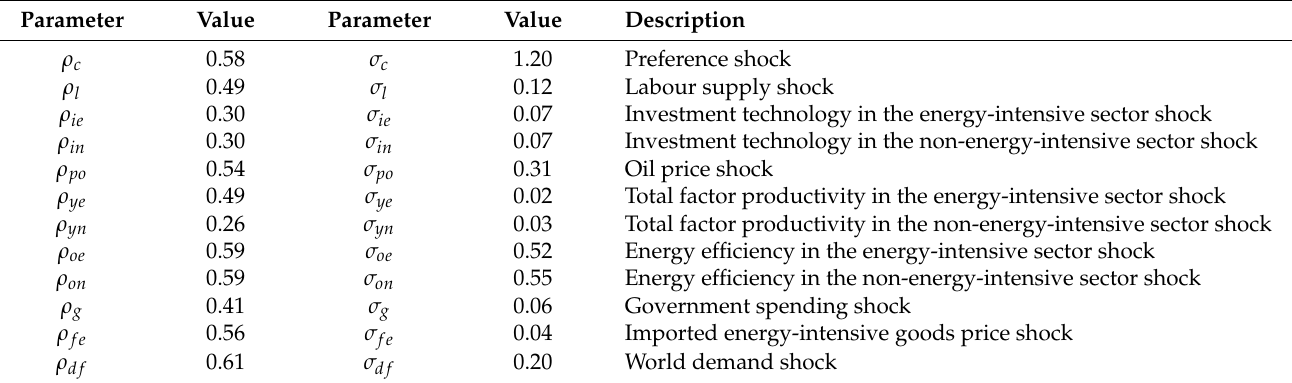
Table A3. Starting values of the shock